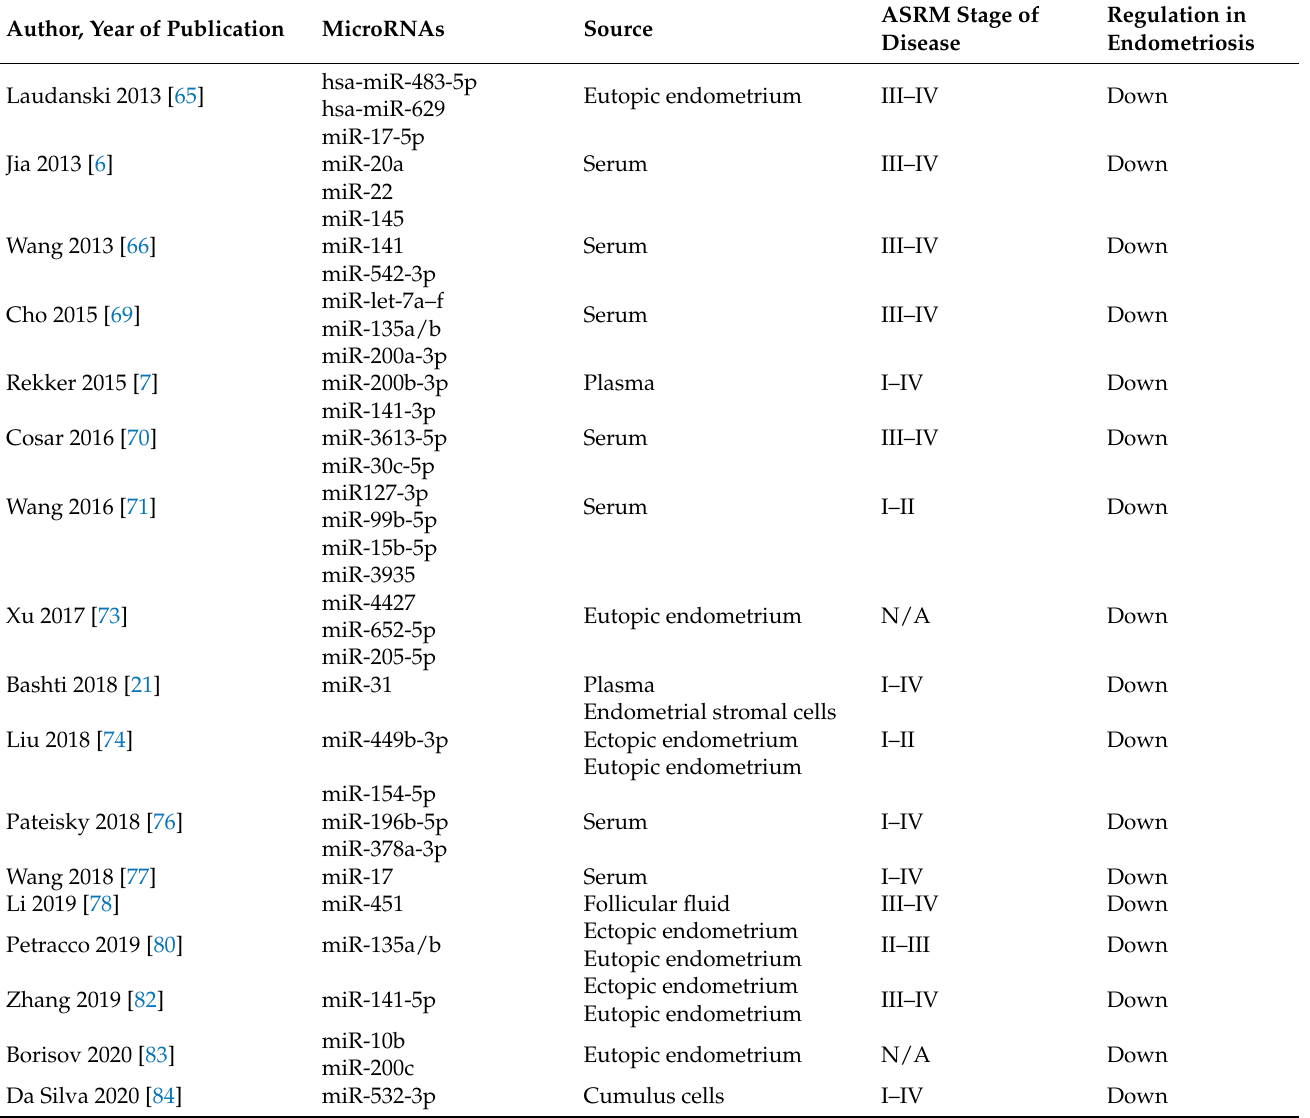
Table 3. Downregulated microRNA expression profiles in patients with